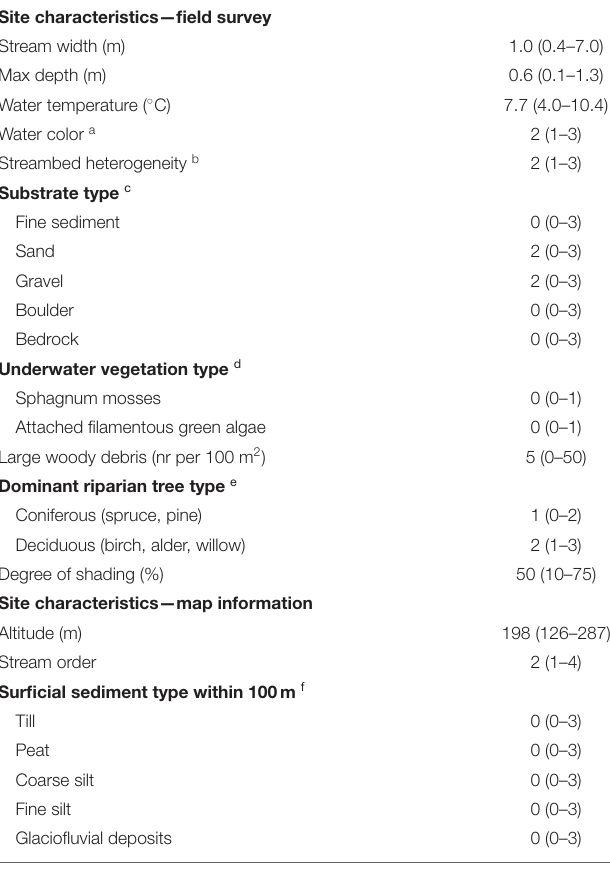
TABLE 1 | Median (range) of local site/habitat characteristics for 47 electrofishing sites. Site characteristics—field survey